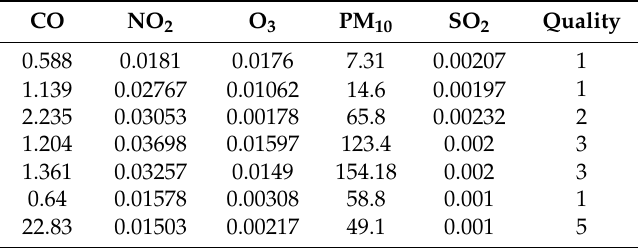
Table 2. Fragment of the sample of observations captured by sensors classified with a quality